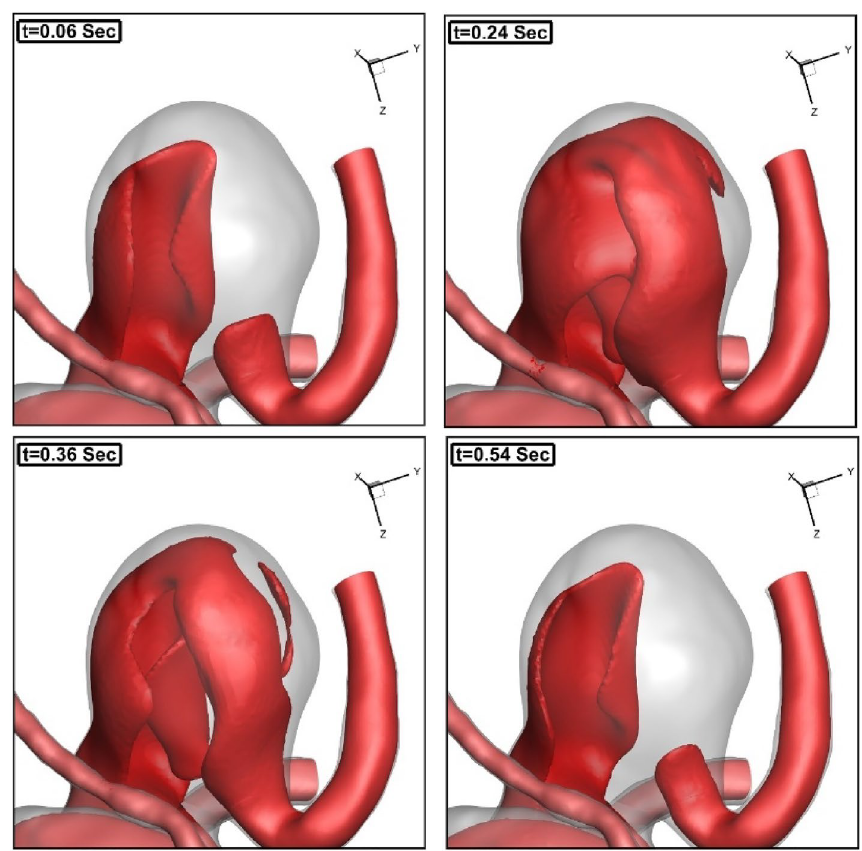
Figure 7. Comparison of is-velocity surface in different stages.